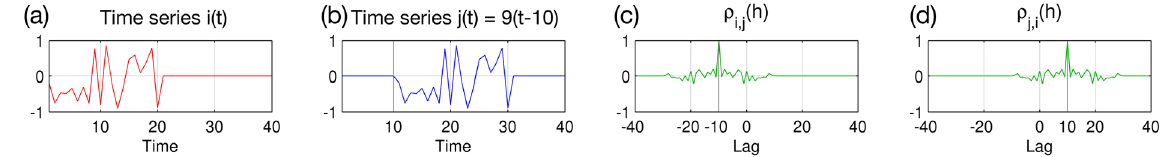
Figure 5. A toy example of cross-correlation. Time series j is a delayed time series i by 10. Therefore cross- correlation (i,j) peaks at the lag of − 10 and cross-correlation (j,i) peaks at the lag of